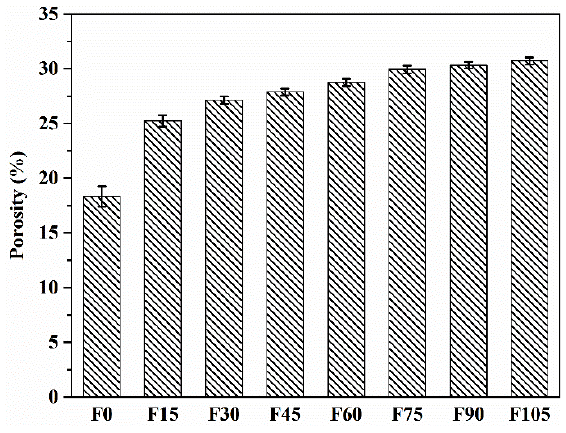
Figure 11. Porosities of F0–F105.